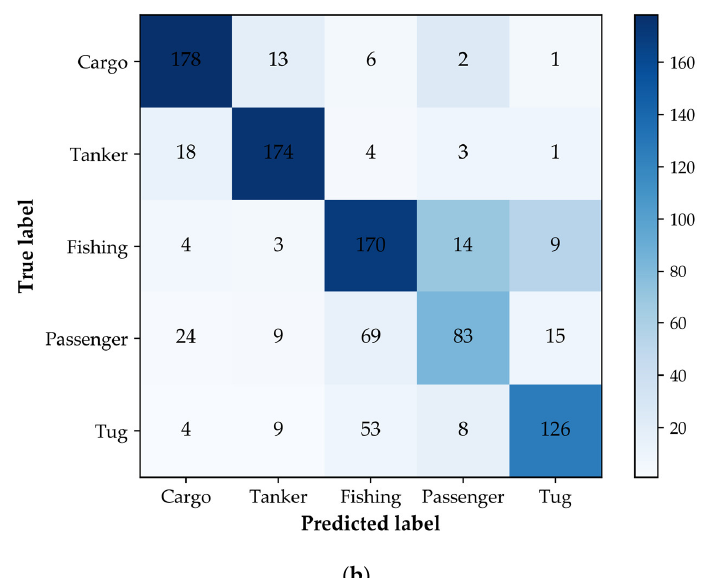
Figure 4. The confusion matrix of the five types of ship test samples considering the geometric fea- tures. ( a ) The confusion matrix of the SVM; ( b ) the confusion matrix of the RF.